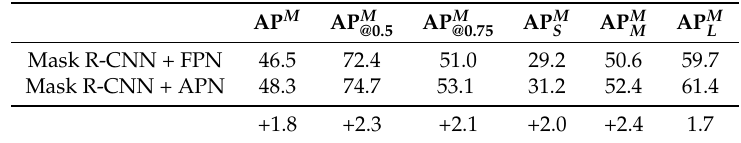
Table 2. The value of instance segmentation results for the COCO dataset. All entries are single-model